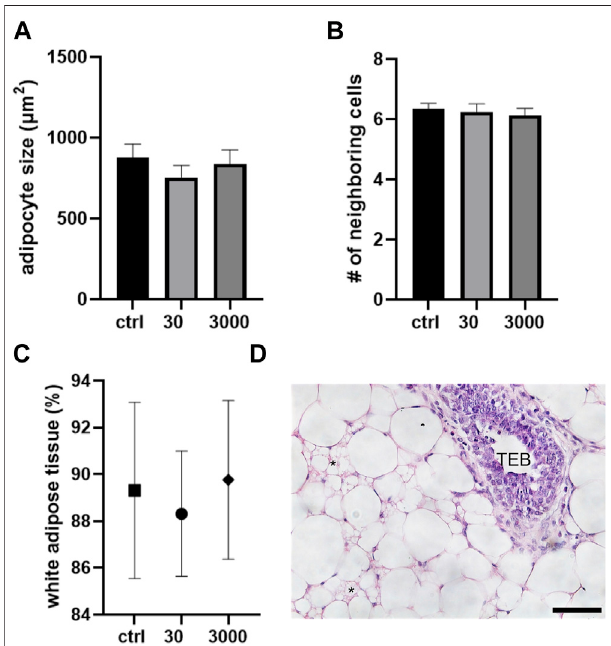
FIGURE 4 | Oxybenzone and brown adipose tissue at puberty. (A) Size of brown adipocytes by treatment group. (B) Number of neighboring cells in the brown adipose tissue. (C) Percent of the mammary stroma comprised of white adipocyte tissue. (D) White and brown adipose tissue in the mammaryfatpad.*indicatesbrownadipocytes.Theepithelialstructureinthis image is a TEB. Scale bar = 20 μ